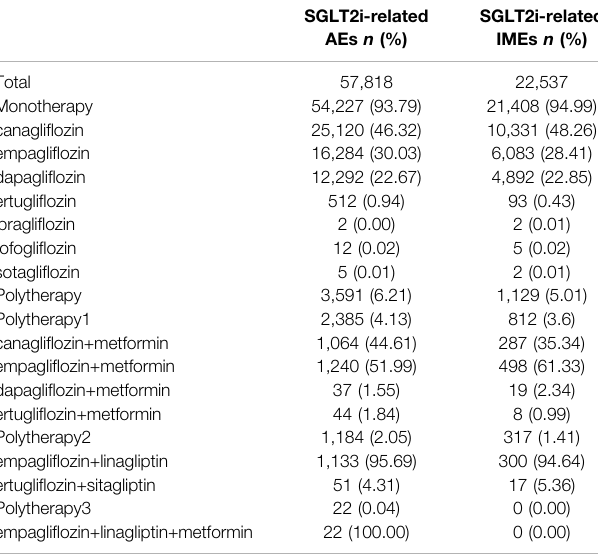
TABLE 1 | Distribution of SGLT2i across therapies a . TABLE 2 | Characteristics of patients with SGLT2i-related AEs/IMEs a